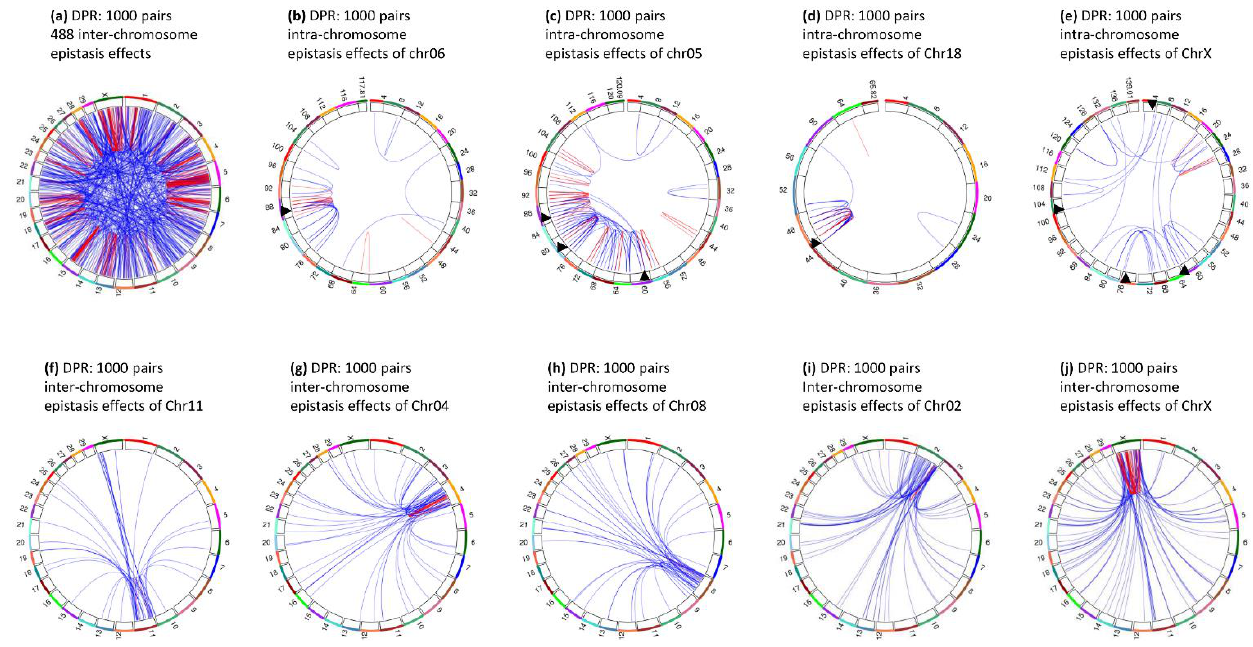
Figure 11. Intra- and inter-chromosome epistasis effects of daughter pregnancy rate (top 1000 pairs). For intra-chromosome epistasis effects, each number on the outer circle is the chromosome number, red color indicates intra-chromosome epistasis effects, and blue color indicates inter-chromosome epistasis effects. For inter-chromosome epistasis effects, each number on the outer circle is the chromosome distance, red color indicating intra-4 Mb epistasis effects and blue color indicating inter-4 Mb epistasis effects. DPR = daughter pregnancy rate. ( a ): Intra- and inter-chromosome epistasis effects of all chromosomes for daughter pregnancy rate. ( b ): Intra-chromosome epistasis effects of Chr06 for daughter pregnancy rate. ( c ): Intra-chromosome epistasis effects of Chr05 for daughter pregnancy rate. ( d ): Intra-chromosome epistasis effects of Chr18 for daughter pregnancy rate. ( e ): Intra-chromosome epistasis effects of ChrX for daughter pregnancy rate. ( f ): Inter-chromosome epistasis effects of Chr11 for daughter pregnancy rate. ( g ): Inter-chromosome epistasis effects of Chr04 for daughter pregnancy rate. ( h ): Inter-chromosome epistasis effects of Chr08 for daughter pregnancy rate. ( i ): Inter-chromosome epistasis effects of Chr02 for daughter pregnancy rate. ( j ): Inter-chromosome epistasis effects of ChrX for daughter pregnancy rate.